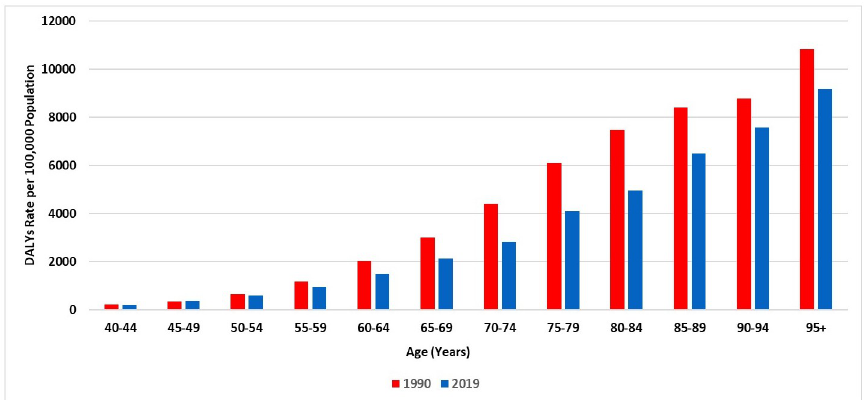
Fig 6. The DALYs rate of COPD in Saudi Arabia (1990 and 2019), stratified by age.